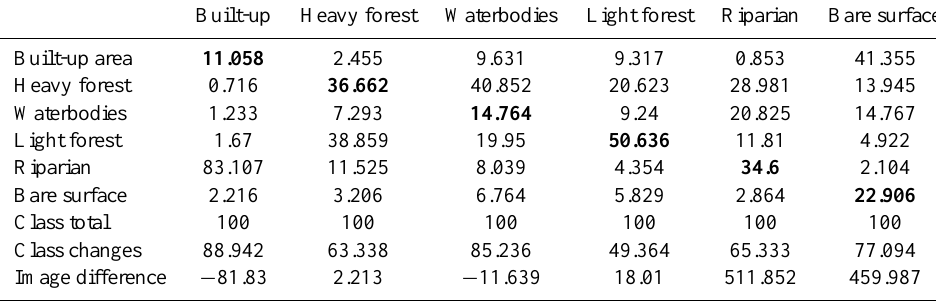
Table 4. Change detection matrix between 1984 and 2000 (%).